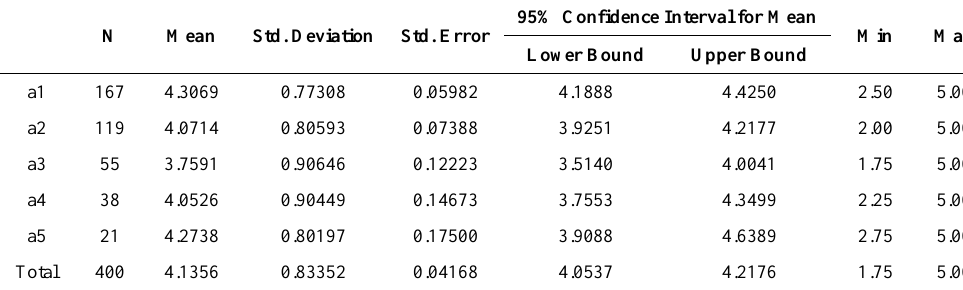
Table 11. Descriptive statistics for age about customer loyalty